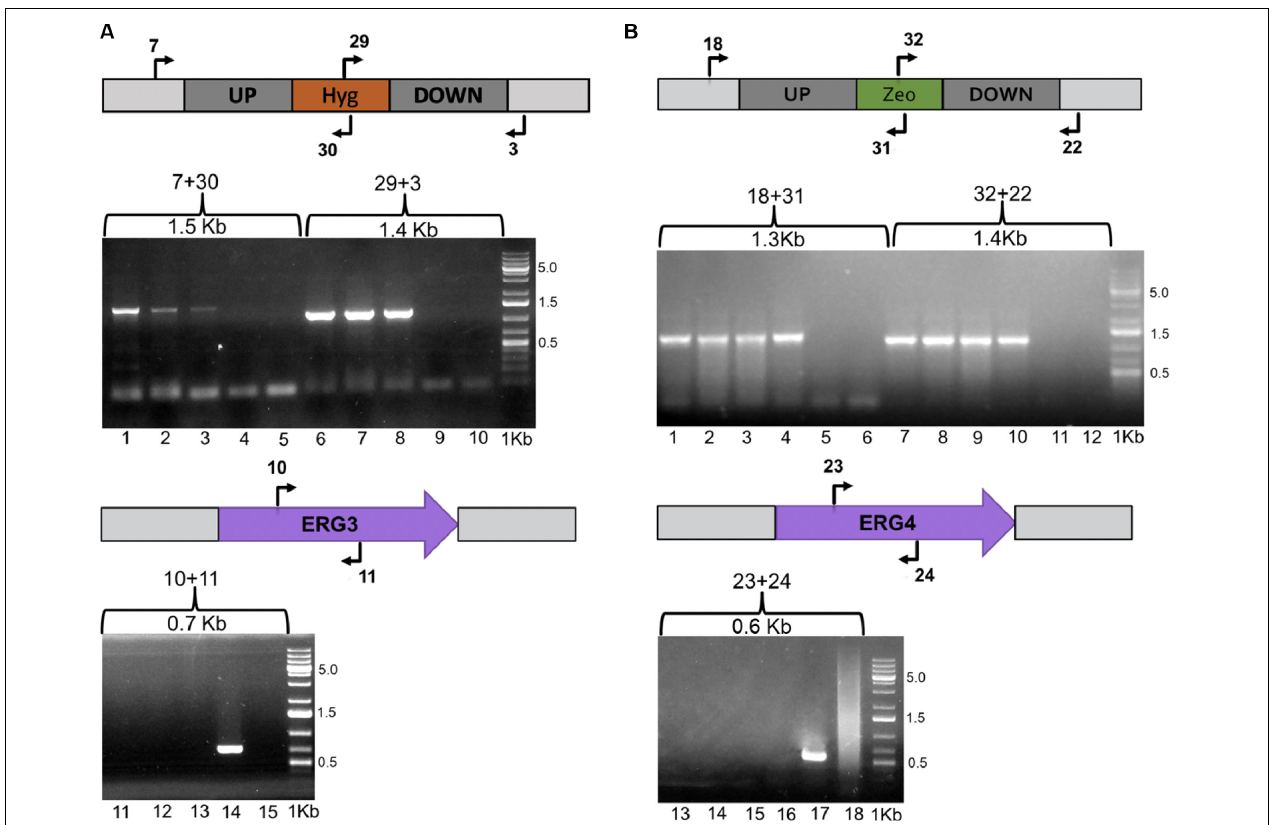
FIGURE 3 | Evaluation of the (cid:49) erg3 and (cid:49) erg4 gene mutations. The X. dendrorhous ERG3 and ERG4 genes were replaced by hygromycin B and zeocin resistance modules through homologous recombination, respectively, which was confirmed by PCR analysis. Schemes including the primers used in the analysis ( Supplementary Table S1 ) and the expected PCR-product size are indicated in the figure. (A) The replacement of the ERG3 locus by the hygromycin B resistance module was confirmed with primer pairs 7 + 30 and 29 + 3, and the presence of the ERG3 gene was confirmed with primer pair 10 + 11. Lanes 1, 2, 3, 6, 7, 8, 11, 12, and 13 correspond to the analysis of the three transformants obtained; lanes 4, 9 and 14 to the parental strain CBS 6938, and lanes 5, 10, and 15 to PCR negative controls. (B) The replacement of the ERG4 locus by the zeocin resistance module was confirmed with primer pairs 18 + 31 and 32 + 22, and the presence of the ERG4 gene was confirmed with the primer pair 23 + 24. Lanes 1, 2, 3, 4, 7, 8, 9, 10, 13, 14, 15, and 16 correspond to the analysis of three transformants; lanes 5, 11 and 17 correspond to the parental strain CBS 6938, and lanes 6, 12 and 18 correspond to PCR negative controls. 1 Kb Plus was used as molecular weight marker 0.5, 1.5, and 5.0 corresponding to the molecular weight sizes in